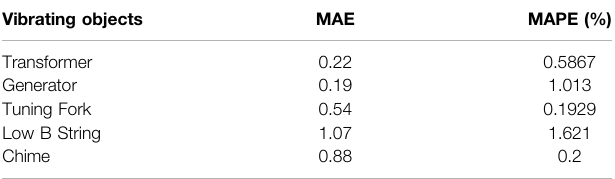
TABLE 4 | Frequency calculation error under different videos. Vibrating objects